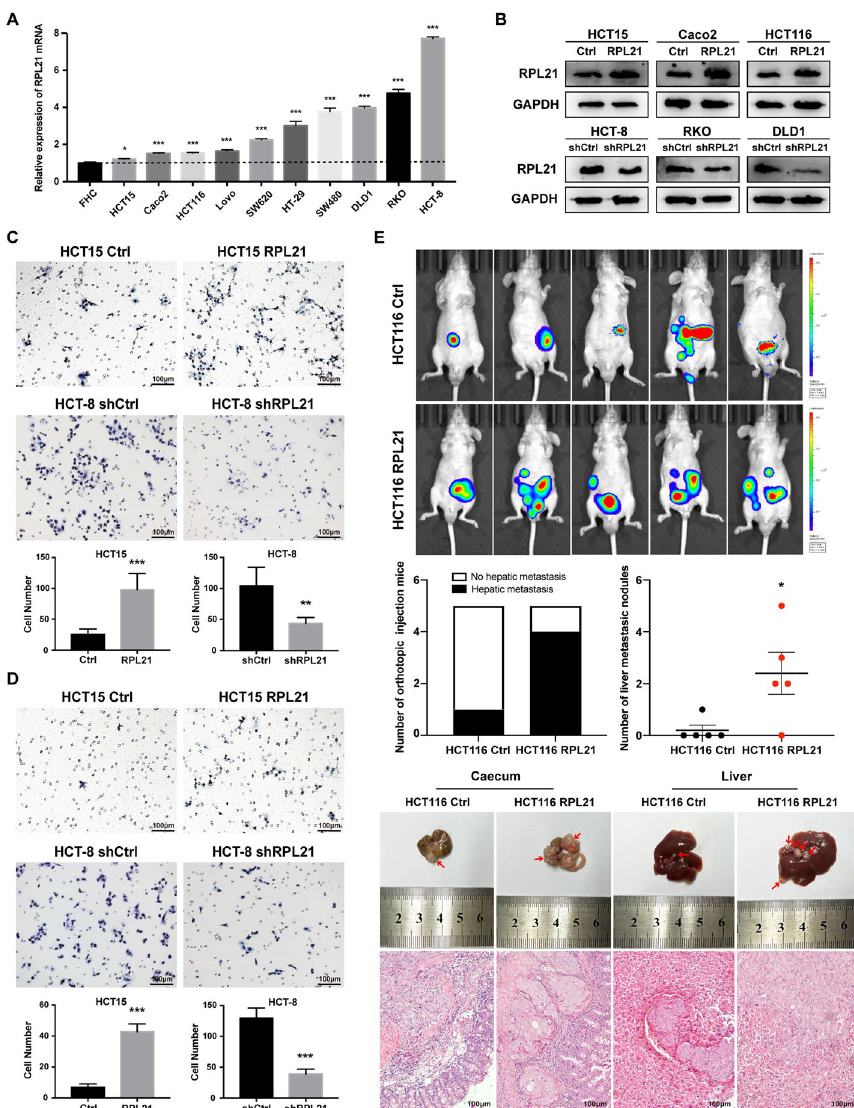
Fig. 2 RPL21 promotes CRC cell migration, invasion and liver metastasis. A The relative expression of RPL21 mRNA in ten CRC cell lines and FHC was detected by qRT–PCR. Mean SD, n 3, *** p < 0.001, ± = * p < 0.05, Student’s t -test. B The establishment of RPL21 stable overexpression (HCT15, Caco2, and HCT116) and knockdown (HCT-8, RKO, and DLD1) cell lines. RPL21 protein expression was detected by western blotting. C The migration ability of CRC cells was detected by the transwell migration assay (scale, 100 μm). Mean SD, n 5, *** p < 0.001, ** p < 0.01, Student’s t -test. D The invasion ability of CRC cells was detected by ± = Matrigel-coated Boyden chamber invasion assay (scale, 100 μm). Mean SD, n 5, *** p < 0.001, Student’s ± = t -test. E In vivo bioluminescence imaging photo and representative morphology images with H&E staining images of tumor formation in mouse cecum and liver metastasis (scale, 100 μm), using the orthotopic CRC mouse model injected with HCT116 Ctrl or HCT116 RPL21 cells. The red arrowheads indicate the tumors in situ or the liver metastatic nodules. The number of liver metastatic nodules in each mouse was counted under the microscope. Mean SD, n 5, * p < 0.05, Student’s t ± =